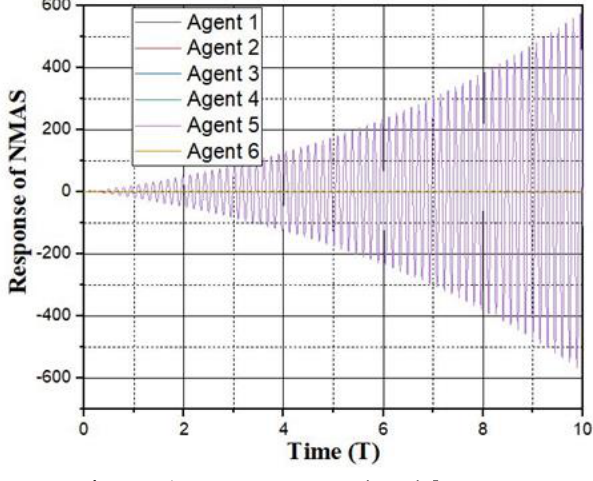
Fig. 6: Divergent response when delay =